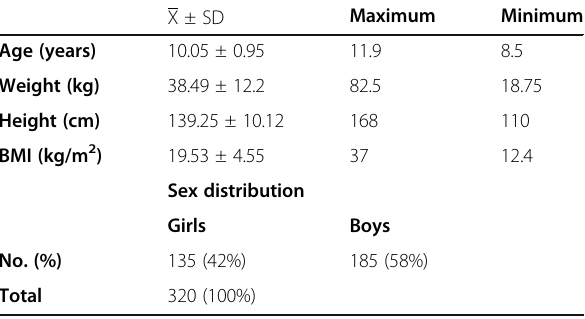
Table 1 Descriptive characteristics of the children